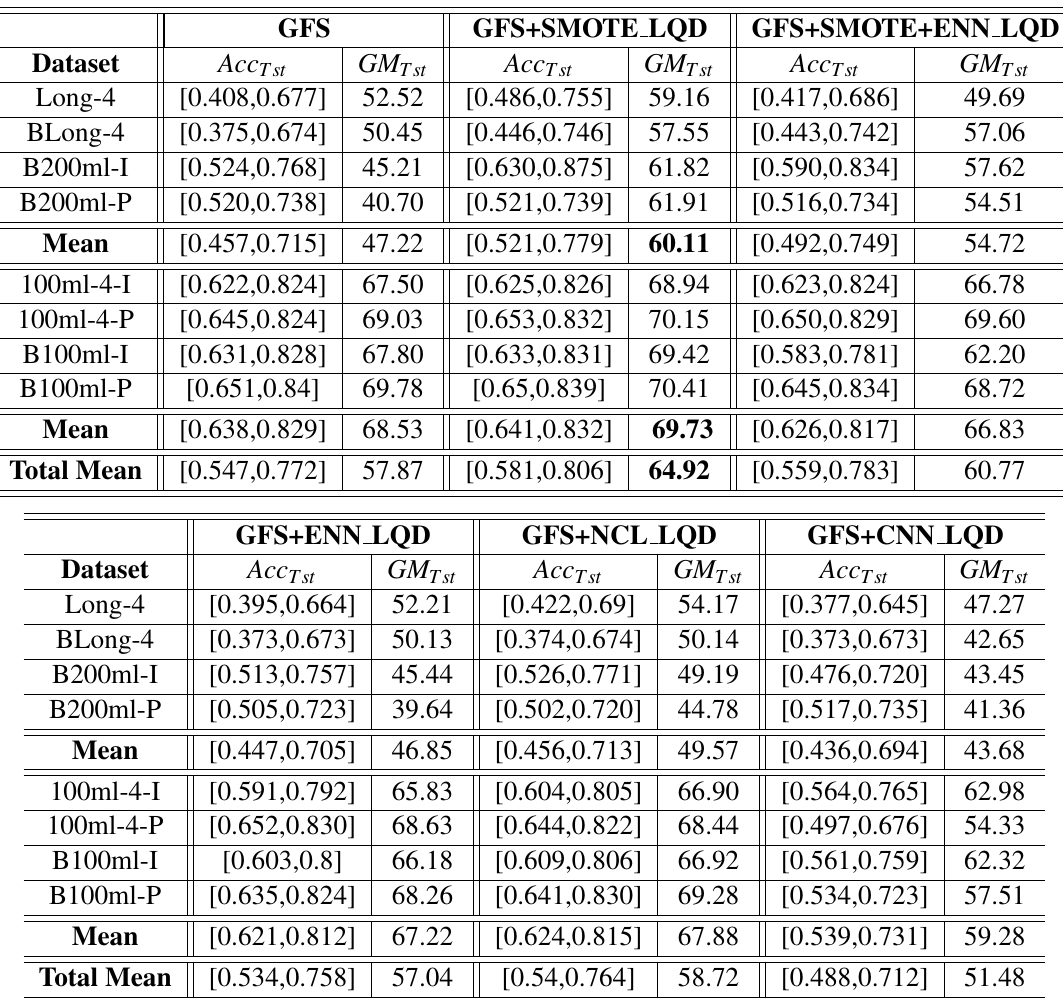
Table 4: Means of 100 repetitions of the GFS from the low quality Athletic’s datasets with 5 labels/variable with the original dataset and preprocessed with several preprocessing